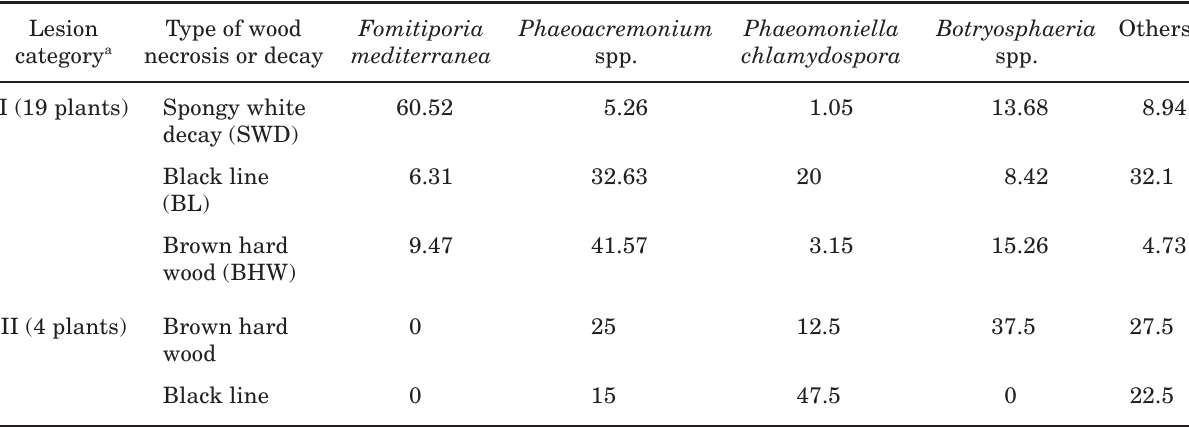
Table 1. Fungi obtained from isolation of wood tissue from 23 esca affected grapevines during the years 2002, 2003 and 2004. Vines were collected from a single plot in the Dão wine region.